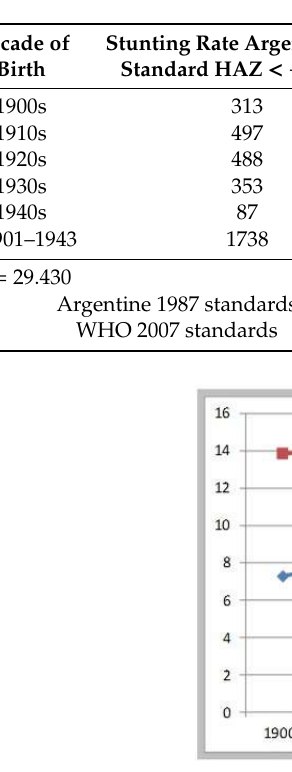
Table 4. Stunting rates by decade Patricios Battalion b.1901–1943.